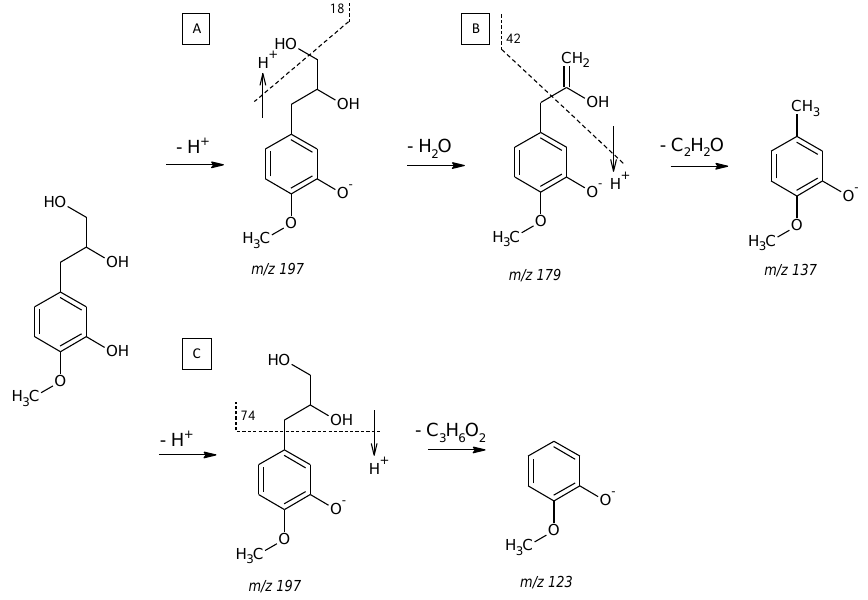
Figure 3 Figure 3. Proposed deprotonated molecular species fragmentation for compound 5 in negative ionisation mode. Dashed lines indicate the